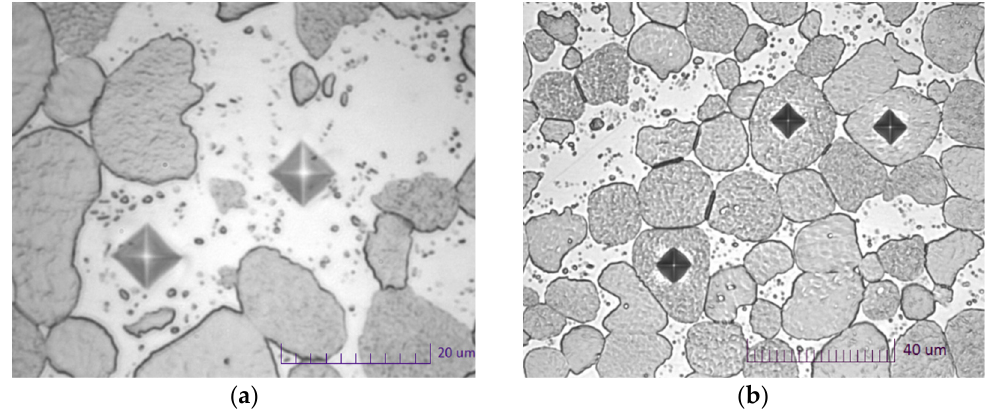
Figure 12. View of indenter imprints in the matrix and tungsten grains (with lens magnification: ( a )—×100, ( b )—×50).